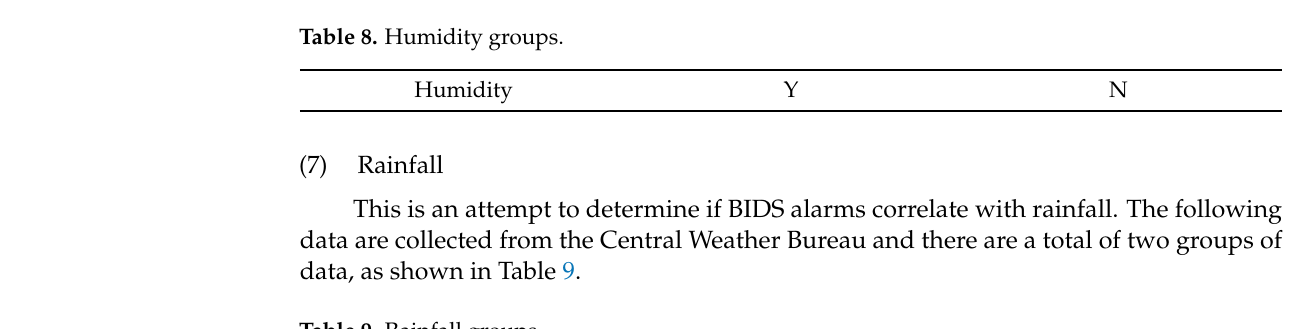
Table 9. Rainfall groups.